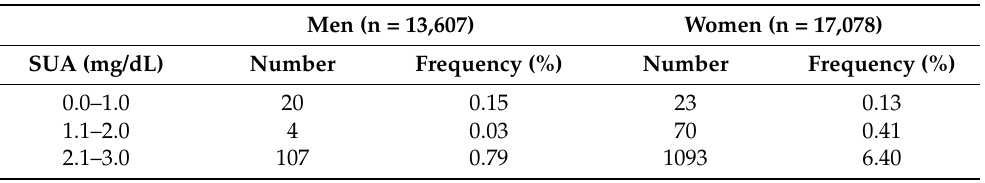
Table 3. Prevalence of low SUA concentration in individuals undergoing a general health examination in Japan [11].